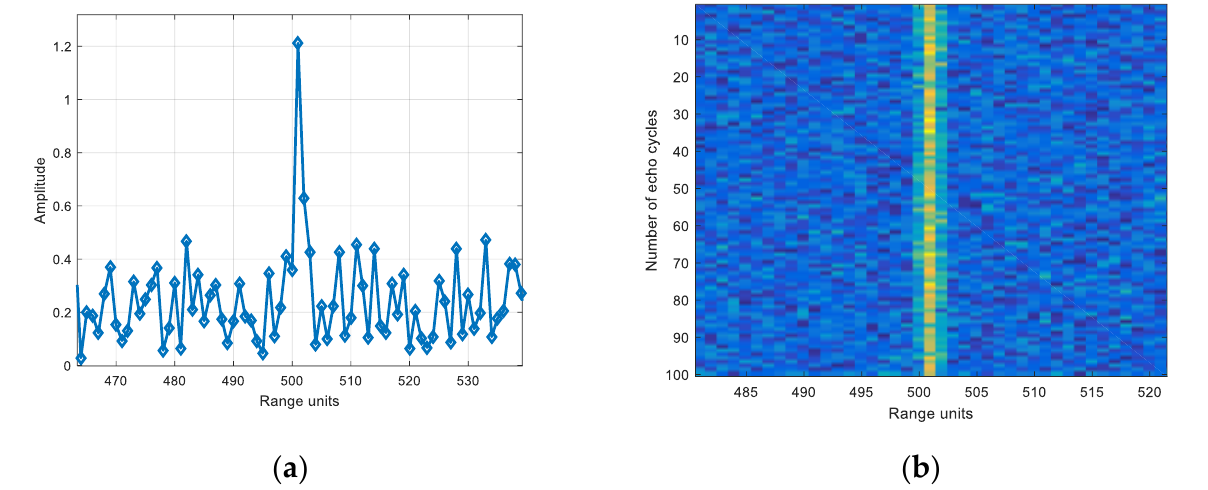
Figure 29. ( a ) Single frame and ( b ) 100 cycles echo diagrams with SNR of 12 dB in narrowband.